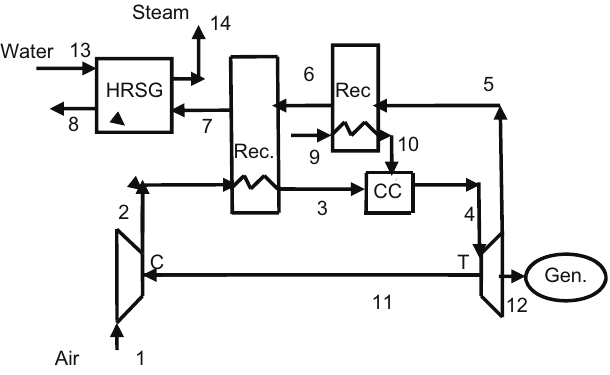
Figure 3: The general diagram of the air - fuel heating cogeneration system ( airfh ) .